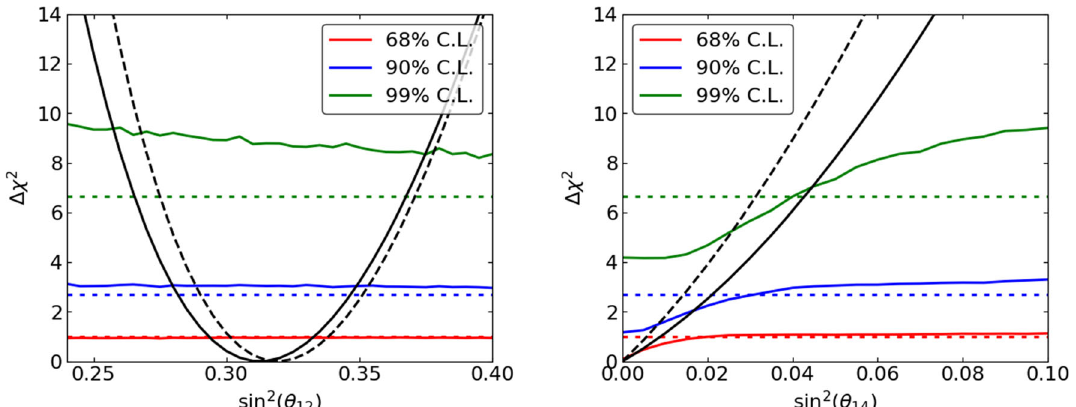
Fig. 4 Critical values of the test statistics Eqs. (3.2) and (3.3) for 68%, 90%, and 99% CL (solid), assuming true values of s 2 = 0 . 313, respectively. Dotted lines indicate the corresponding crit- s 2 12